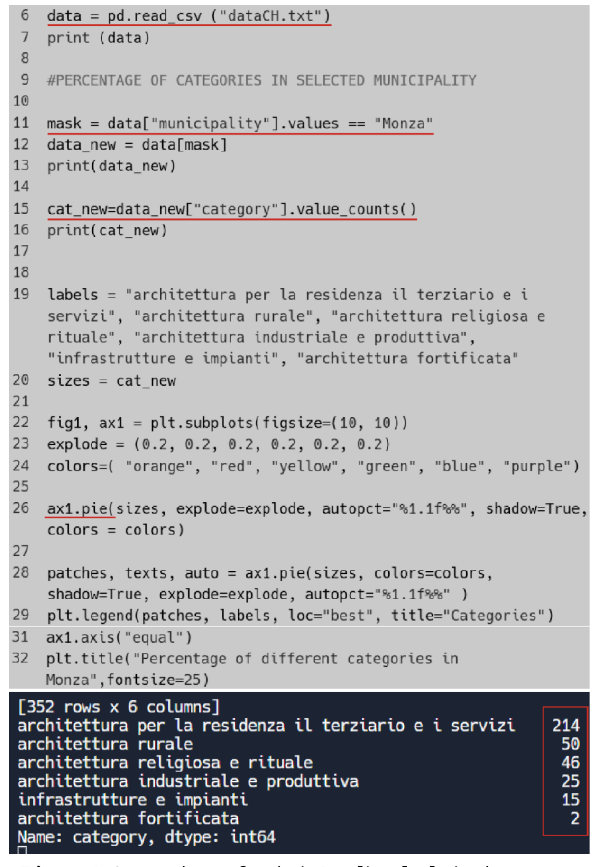
Figure 4. Screenshots of code in Replit calculating how many dissimilar categories of cultural heritage buildings there are in Monza and surroundings, in percentage, and presenting them in a pie chart (see Figure 6, source: D. Jovanović).